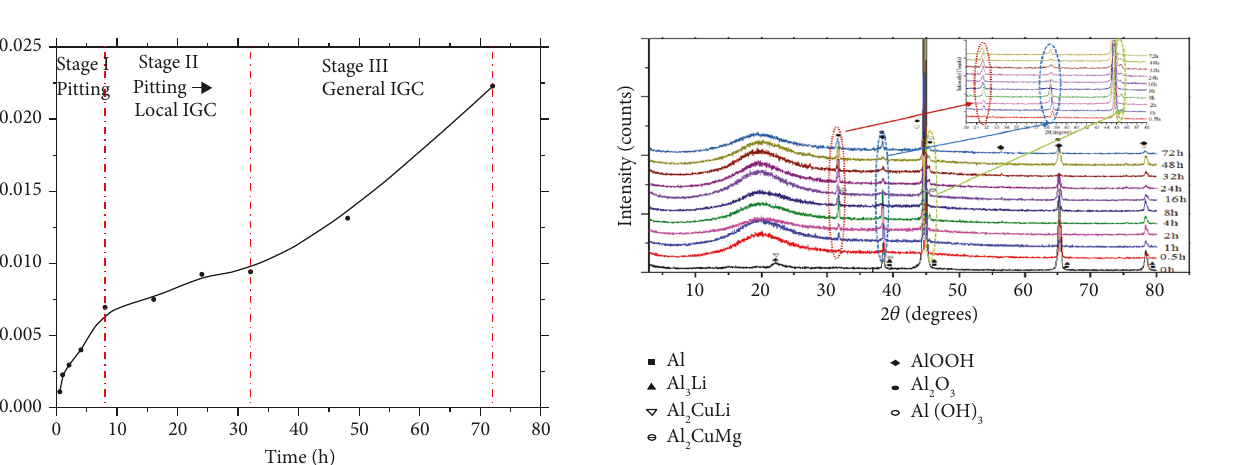
Figure 6: XRD patterns of 2060 Al–Li alloy at different Figure 5: Mass vs. time of corrosion product formed on 2060 Al–Li alloy after salt spray corrosion. Figure 6. 2060-T8 Al–Li alloy contains a lot of precipitate phases (e.g., δ (Al Li), θ (Al Cu), T1(Al CuLi) and S 3 2 2